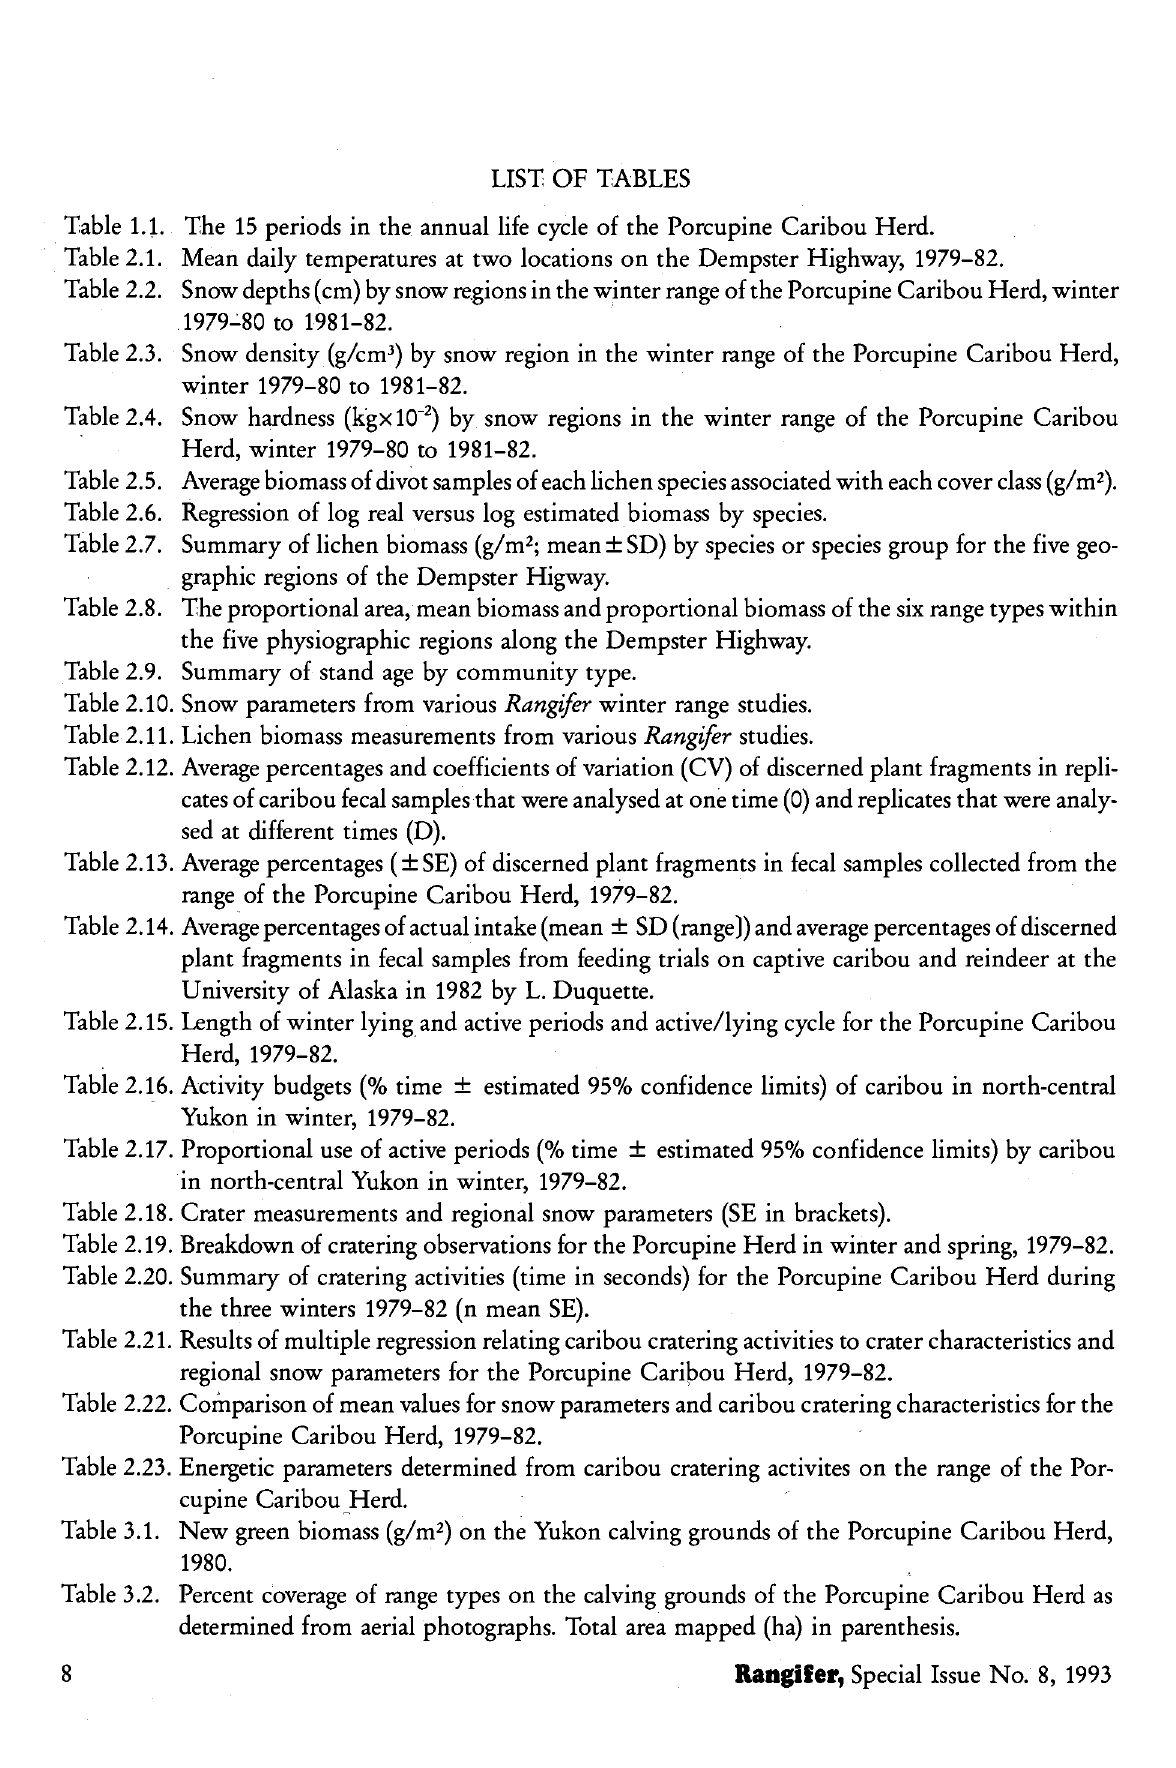
Table 1.1. The 15 periods in the annual life cycle of the Porcupine Caribou Herd. Table 2.1. Mean daily temperatures at two locations on the Dempster Highway, 1979-82. Table 2.2. Snow depths (cm) by snow regions in the winter range of the Porcupine Caribou Herd, winter 1979-80 to 1981-82. Table 2.3. Snow density (g/cm 3 ) by snow region in the winter range of the Porcupine Caribou Herd, winter 1979-80 to 1981-82. Table 2.4. Snow hardness (kgx 10" 2 ) by snow regions in the winter range of the Porcupine Caribou Herd, winter 1979-80 to 1981-82. Table 2.5. Average biomass of divot samples of each lichen species associated with each cover class (g/m 2 ). Table 2.6. Regression of log real versus log estimated biomass by species. Table 2.7. Summary of lichen biomass (g/m 2 ; mean±SD) by species or species group for the five geo graphic regions of the Dempster Higway. Table 2.8. The proportional area, mean biomass and proportional biomass of the six range types within the five physiographic regions along the Dempster Highway. Table 2.9. Summary of stand age by community type. Table 2.10. Snow parameters from various Rangifer winter range studies. Table 2.11. Lichen biomass measurements from various Rangifer studies. Table 2.12. Average percentages and coefficients of variation (CV) of discerned plant fragments in repli cates of caribou fecal samples that were analysed at one time (0) and replicates that were analy sed at different times (D). Table 2.13. Average percentages ( ± SE) of discerned plant fragments in fecal samples collected from the range of the Porcupine Caribou Herd, 1979-82. Table 2.14. Average percentages of actual intake (mean ± SD (range]) and average percentages of discerned plant fragments in fecal samples from feeding trials on captive caribou and reindeer at the University of Alaska in 1982 by L. Duquette. Table 2.15. Length of winter lying and active periods and active/lying cycle for the Porcupine Caribou Herd, 1979-82. Table 2.16. Activity budgets (% time ± estimated 95% confidence limits) of caribou in north-central Yukon in winter, 1979-82. Table 2.17. Proportional use of active periods (% time ± estimated 95% confidence limits) by caribou in north-central Yukon in winter, 1979-82. Table 2.18. Crater measurements and regional snow parameters (SE in brackets). Table 2.19. Breakdown of cratering observations for the Porcupine Herd in winter and spring, 1979-82. Table 2.20. Summary of cratering activities (time in seconds) for the Porcupine Caribou Herd during the three winters 1979-82 (n mean SE). Table 2.21. Results of multiple regression relating caribou cratering activities to crater characteristics and regional snow parameters for the Porcupine Caribou Herd, 1979-82. Table 2.22. Comparison of mean values for snow parameters and caribou cratering characteristics for the Porcupine Caribou Herd, 1979-82. Table 2.23. Energetic parameters determined from caribou cratering activités on the range of the Por cupine Caribou Herd. Table 3.1. New green biomass (g/m 2 ) on the Yukon calving grounds of the Porcupine Caribou Herd, 1980. Table 3.2. Percent coverage of range types on the calving grounds of the Porcupine Caribou Herd as determined from aerial photographs. Total area mapped (ha) in